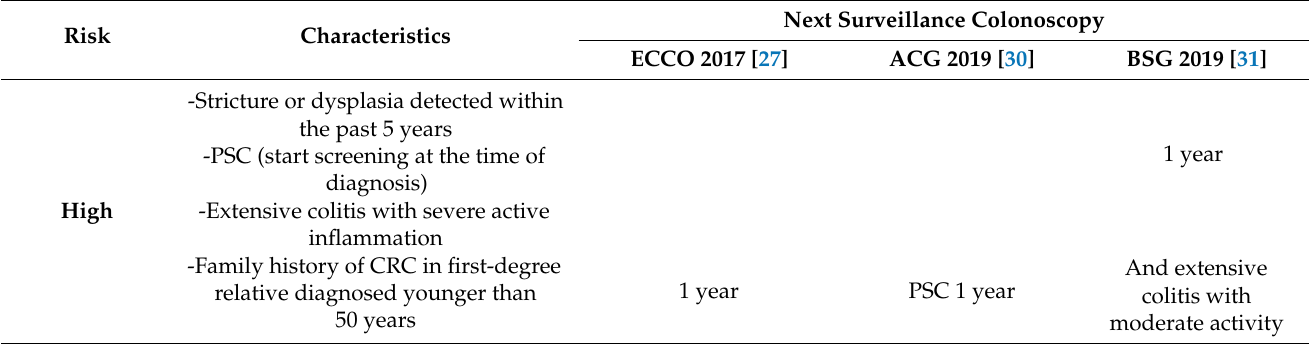
Table 1. Colonoscopy surveillance recommendations according to the main international